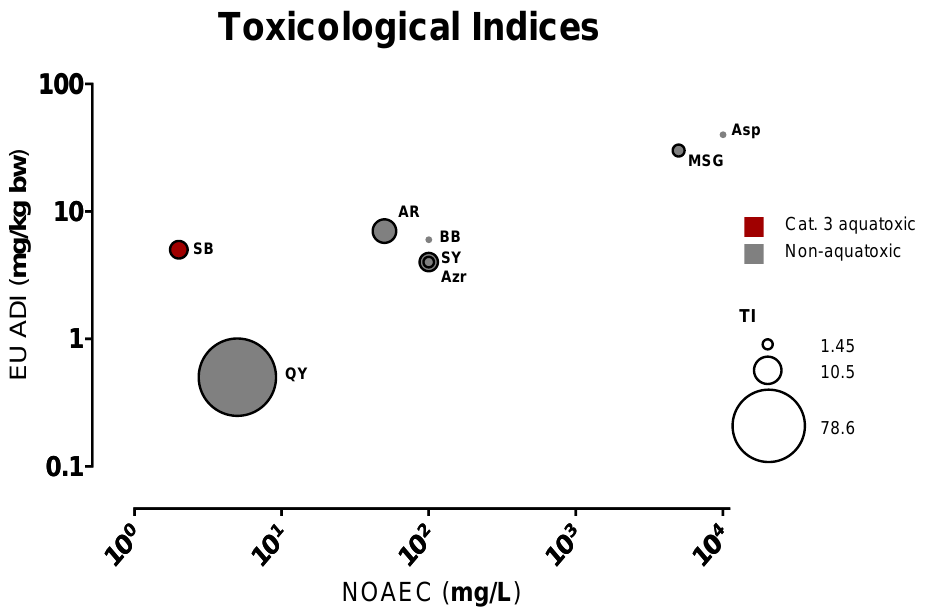
Figure 3. Toxicological indices of the tested FAs. NOAECs are plotted against their European ADIs [34–37,39–42]. Food additives abbreviations as listed in Table 1; red color indicates aquatoxic, grey non-aquatoxic compounds. The bubble sizes represent the teratogenic index (TI); Substances without computable LC 50 and EC 50 (thus no TI) are displayed as small, borderless dots.